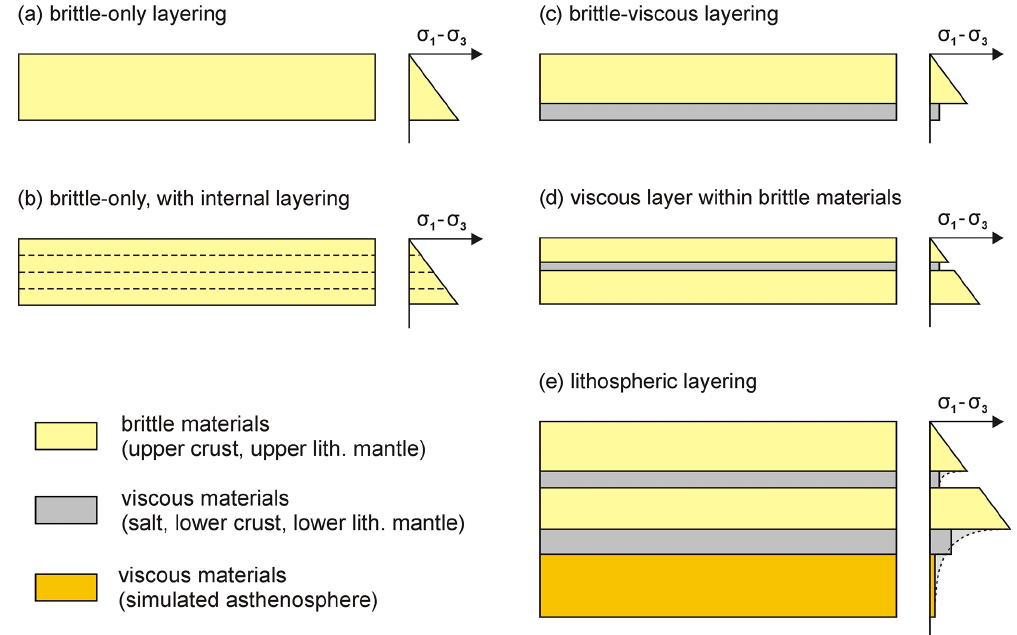
Figure 4. Examples of model layering used for basin inversion experiments seen in section view, including schematic strength profiles. (a– d) Crustal-scale layering options. (a) Homogeneous layer of brittle model material. (b) Brittle model material interlayered with other brittle materials for visualization or to simulate brittle-style detachments (e.g. Buchanan and McClay, 1991). (c) Brittle–viscous layering, with a cover of brittle model material overlying a viscous detachment layer that decouples the brittle cover from the (rigid) model base. (d) Viscous detachment within the brittle model materials (such as a weak shale or salt layer, e.g. Brun and Nalpas, 1996). (e) Brittle–viscous multilayer arrangement representing the whole of the lithosphere (e.g. Cerca et al., 2010). The dotted line in the strength profile of panel (e) indicates a schematic lithospheric strength profile that is approximated in the model (see, e.g. Brun,